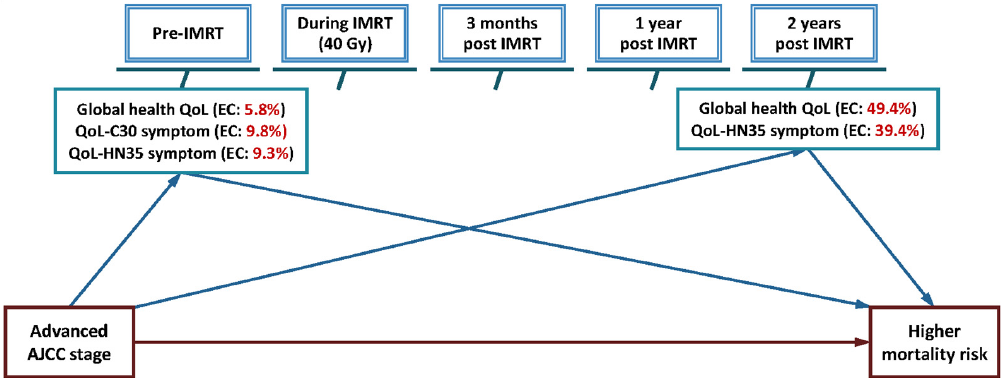
Figure 3. The intermediated paths of quality of life (QoL) scales at different intensity-modulated radiation therapy (IMRT)- related time points on the association between advanced AJCC stage (III–IV) and higher mortality risk in nasopharyngeal cancer patient follow-up cohort (intermediated path: Advanced AJCC stage to QoL score to Mortality risk). Note: Effect change (EC) was the excessive effect explained by a specific QoL scale at a time period. Global health QoL, QoL-C30 symptom, and QoL-HN35 symptom denoted the average QoL scores obtained from the EORTC QLQ-C30 global QoL scale, 9 symptom scales/items, and EORTC QLQ-HN35 18 symptom scales/items, respectively. AJCC, American Joint Committee on Cancer; EORTC, European organization for research and treatment of cancer; QoL-C30, the core QoL questionnaire of EORTC; QoL-HN35, the head and neck cancer-specific QoL questionnaire module of EORTC.